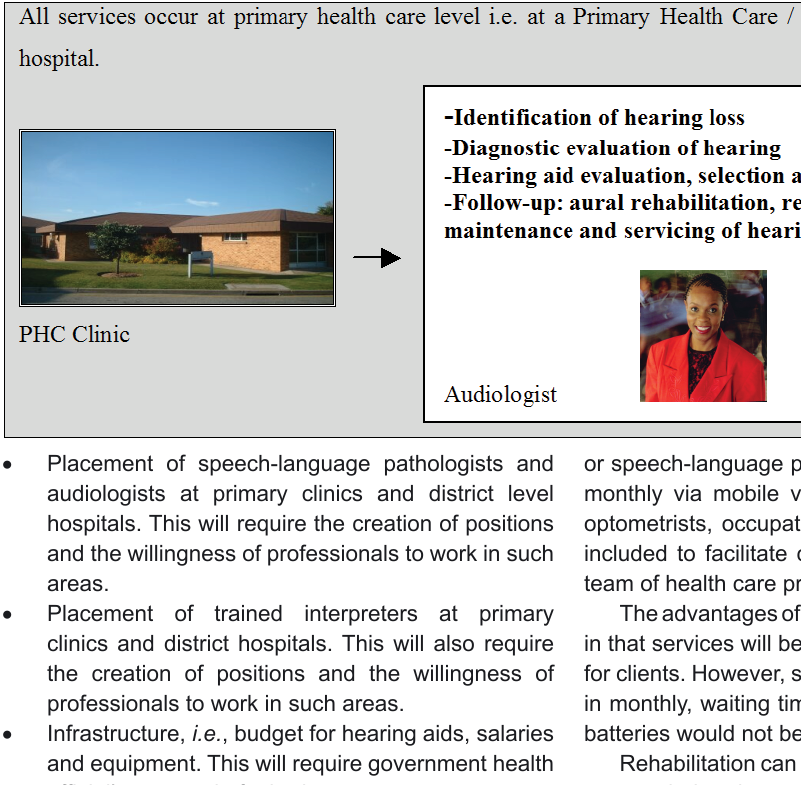
Figure 4. Option one of hearing aid service delivery